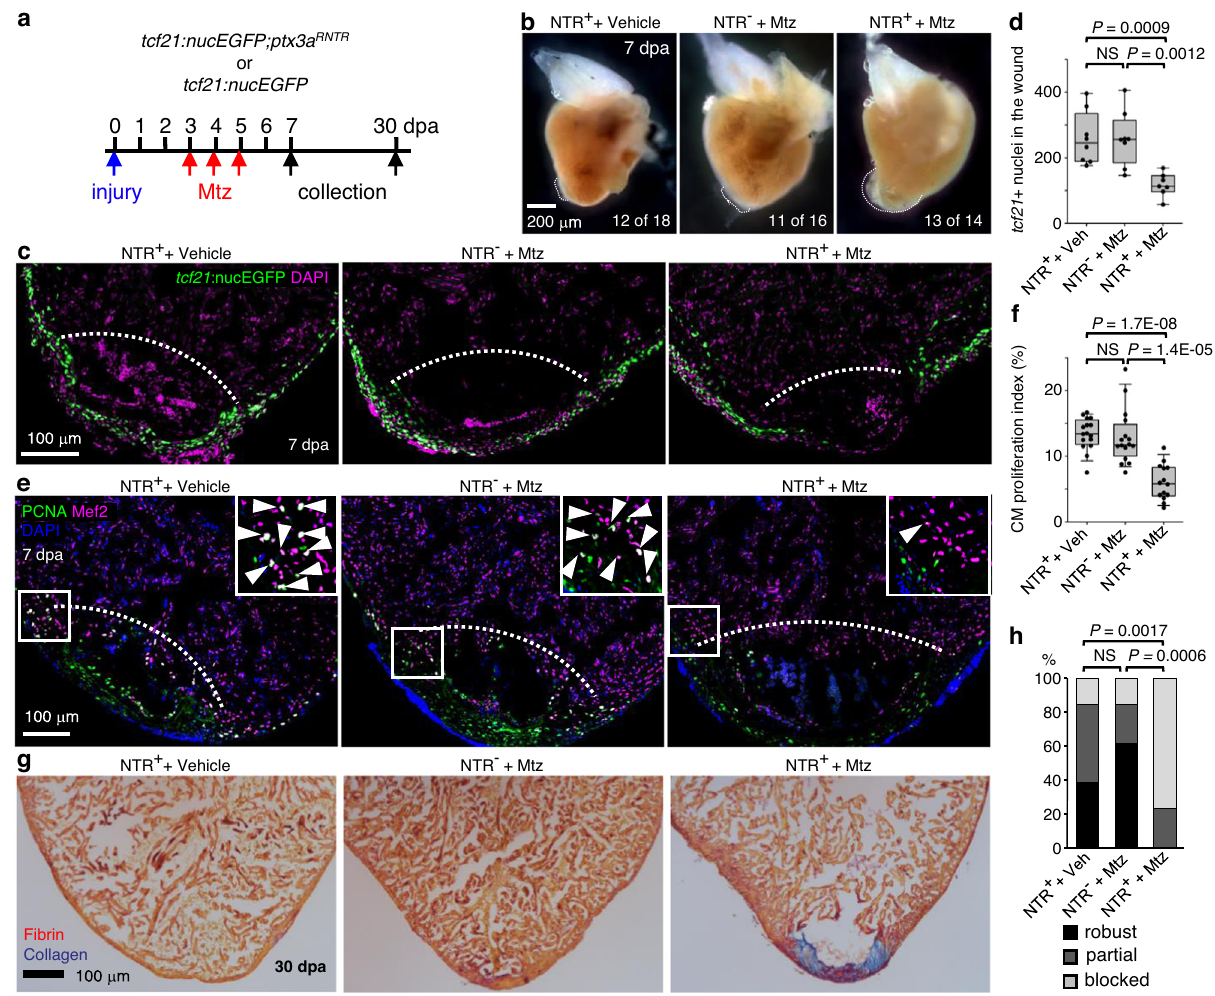
Fig. 7 | aEPCablationblocksheart regeneration. a Experimentaldesign. Siblings carrying the ptx3a RNTR allele and/or the tcf21:nucEGFP reporter were treated with 5mM Mtz or vehicle (Ctrl) from 3dpa to 5dpa. b Whole mount images of hearts collected at 7dpa. Dash lines denote the injury sites. Large blood clot and extra tissue were observed in hearts of Mtz treated NTR + animals (13 of 14) but not in thosefromthevehicle-treatedNTR + fi sh(12of18)orMtztreatedNTR - fi sh(11of16). Scale bar, 200 μ m. c Section images of injured ventricles from 3 treatment groups at 7dpa. The epicardial cells are labeled with tcf21: nucEGFP (green). Nuclei were stainedwithDAPI(magenta).Whitedashedlinesindicatetheinjurysites.Scalebar, 100 μ m. d Quanti fi cationofEGFP + cellsinthewoundregionfromexperimentsin c . From left to right, n =8, 8, and 7, respectively. NS not signi fi cant. Two-tailed Stu- dent ’ s t test. e Section images of injured ventricles from 3 treatment groups at 7dpa. Ventricular CM proliferation was assessed by anti-PCNA (green) and Mef2